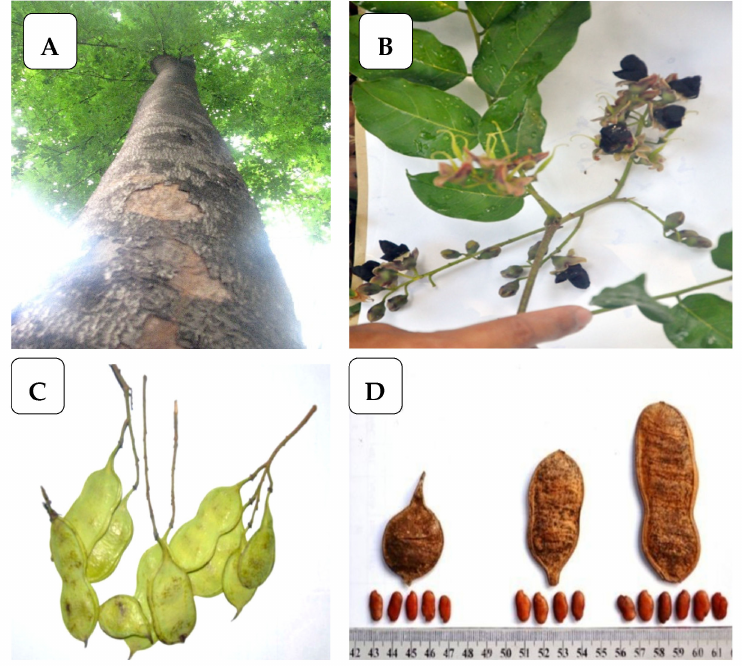
Figure 2. Picture of P. mooniana , natural stands ( A ); flowering twigs, flower parts, and pods ( B ); fruit morphology ( C , D )